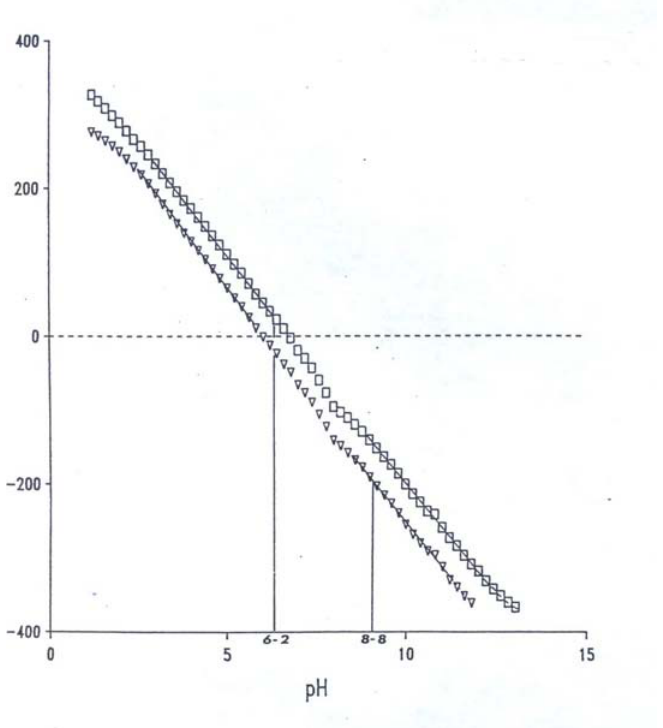
Figure 3. Potential vs. pH plot of buffers (CRC) (cid:31) Fisher glass electrode (cat.# 13-639-3); ∇ Fisher glass electrode (cat.#